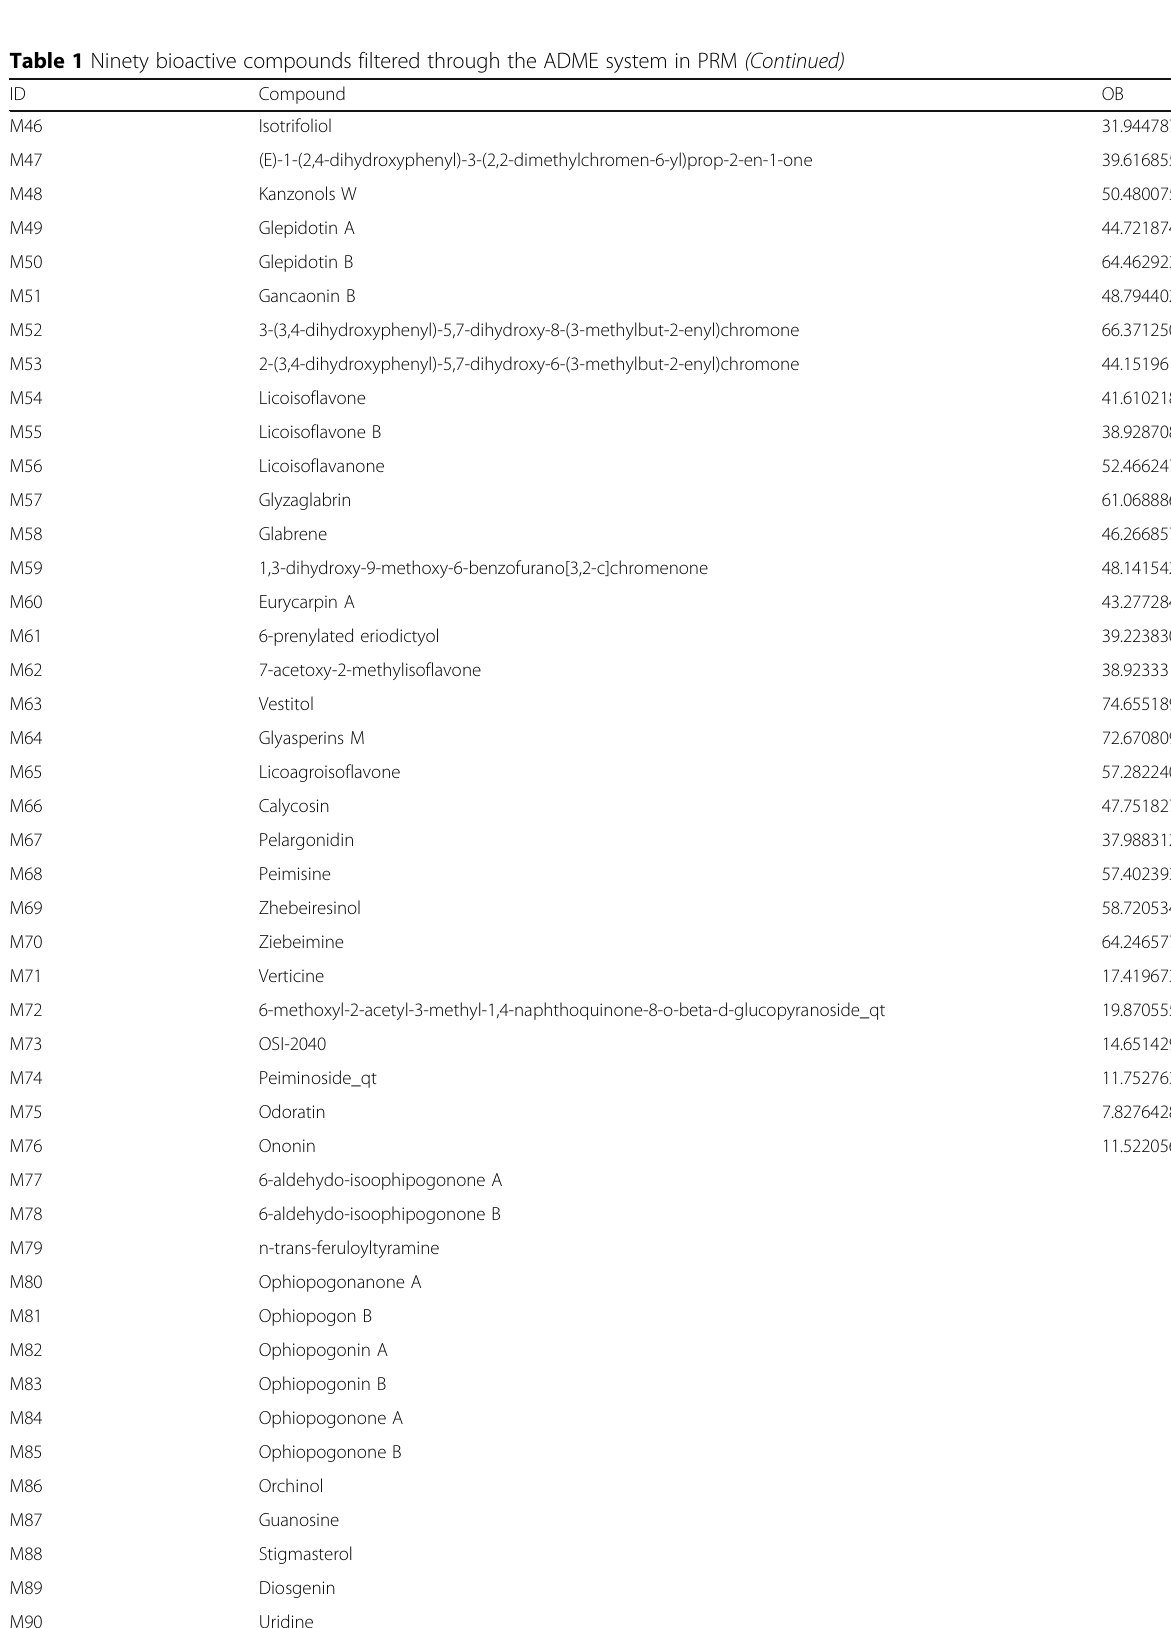
Table 1 Ninety bioactive compounds filtered through the ADME system in PRM